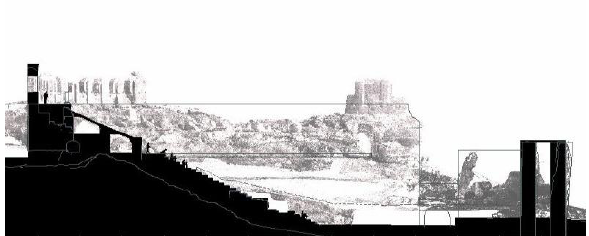
Figure 5. Restoration proposal: Section of the